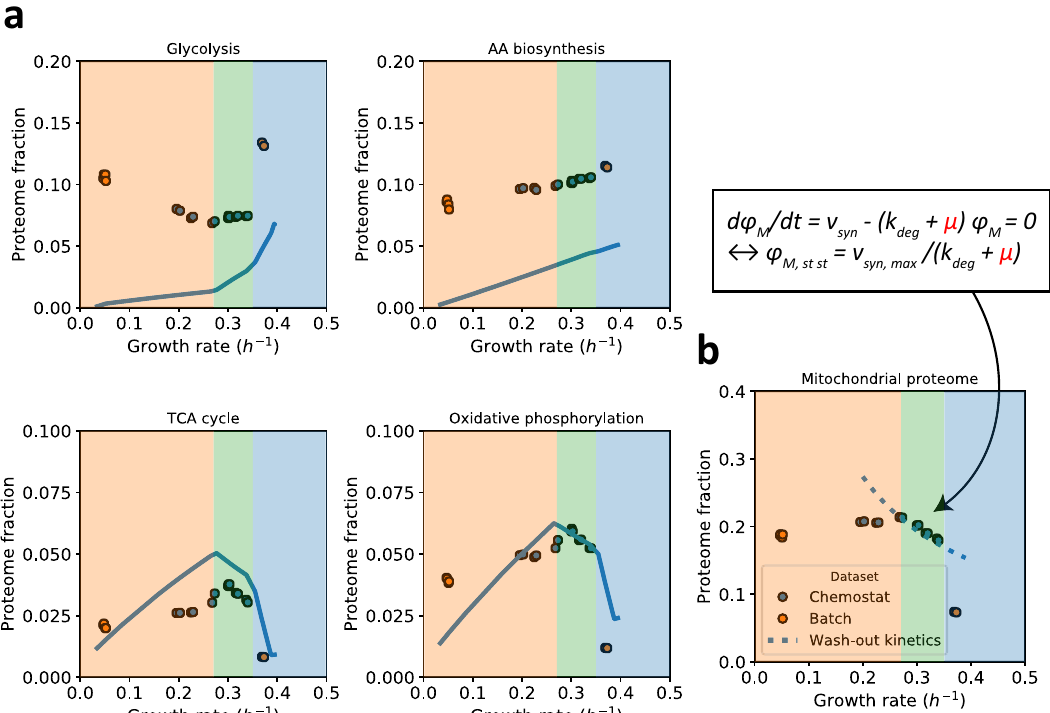
Fig. 3 Proteomics data of selected pathways as a function of glucose availability. Blue symbols are glucose-limited chemostat data; orange symbols are controlled batch experiments with excess trehalose (lowest growth rate) or glucose (highest growth rate) a Comparison of predicted minimal proteome fractions to sustain growth with the experimentally determined proteome fraction for four pathways. The ratio between the two represents an estimate of the saturation level of the constituent enzymes. Lines represent the model; experimental data are symbols. b Decay of steady-state mitochondrial protein fraction with growth rate at onset of ethanol formation suggests a maximal rate of mitochondrial biosynthesis v syn ; max . The shading of the different growth regimes is based on the (latest) constraint, actively limiting growth, referring to Fig. 2e. Individual proteins in panel a were mapped to metabolic pathways using a manually-curated pathway annotation fi le (Supplementary Data 5). Source data are provided as a Source Data fi